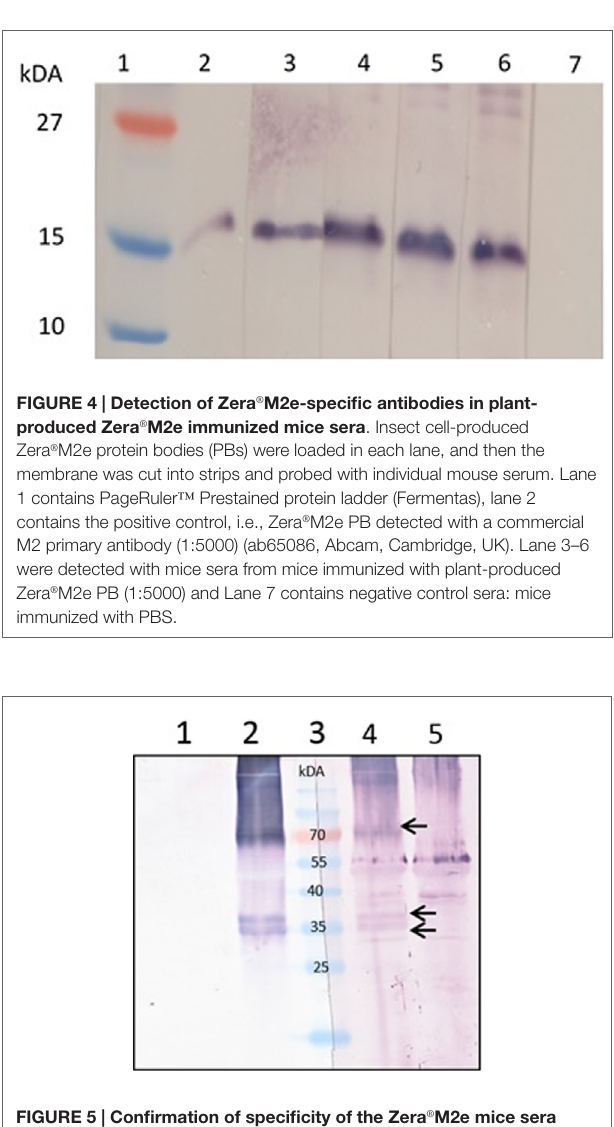
FigUre 5 | confirmation of specificity of the Zera ® M2e mice sera against the fused M2e plant-produced protein . Equal volume of plant-produced 5xM2e_tHA proteins were loaded in each lane. The membranes were cut in the middle and each half was probed either with the commercial M2 antibody or mice serum from mice immunized with plant-produced Zera ® M2e PB. Lanes 1 and 5 contain Agrobacterium - infiltrated crude plant extract (negative control), Lanes 2 and 4 contain the 5xM2e_tHA plant crude extract, and Lane 3 contains PageRuler ™ Prestained protein ladder (Fermentas). Lanes 1 and 2 were detected with commercial M2 (14C2) primary antibody (1:5000). Lanes 4 and 5 were detected with mice sera from mice immunized with plant-produced Zera ® M2e PB